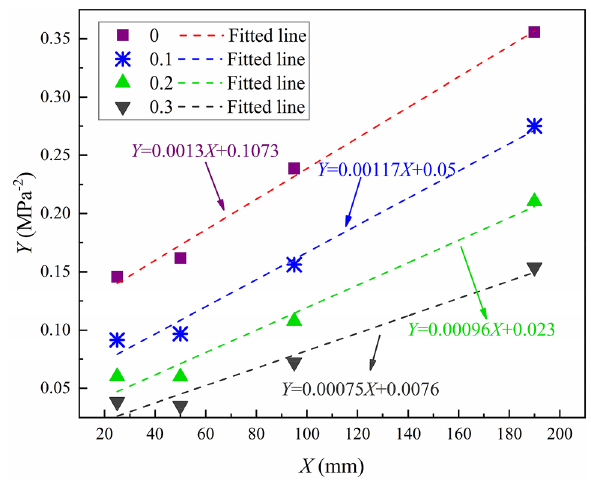
Figure 10. Failure loads transformed under different friction coefficients with the change of specimen